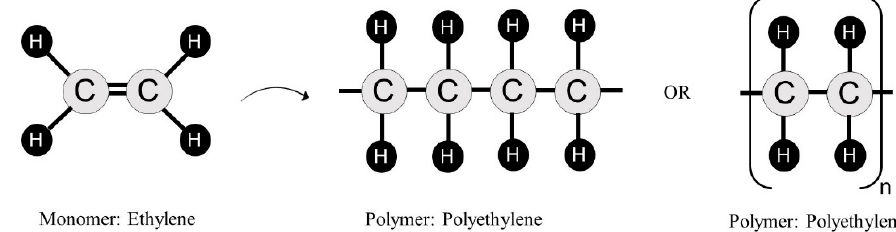
Figure 1. Illustration of the ethylene polymerization.